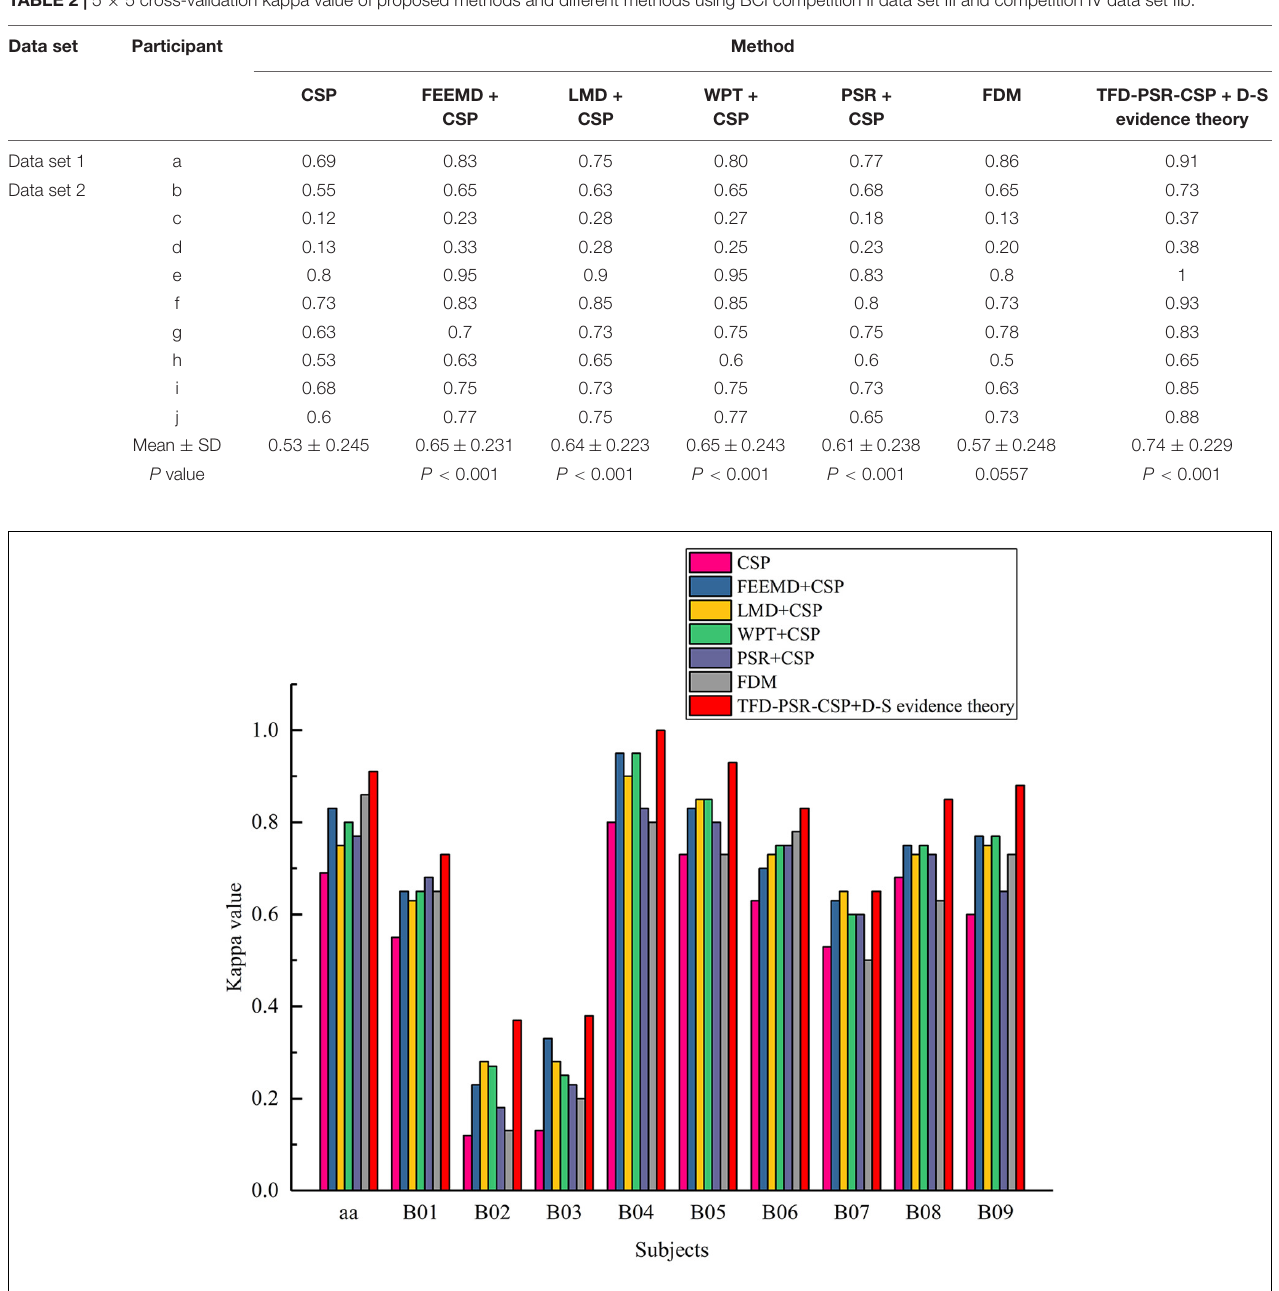
FIGURE 4 | Kappa values of all participants in data set 1 and data set 2.